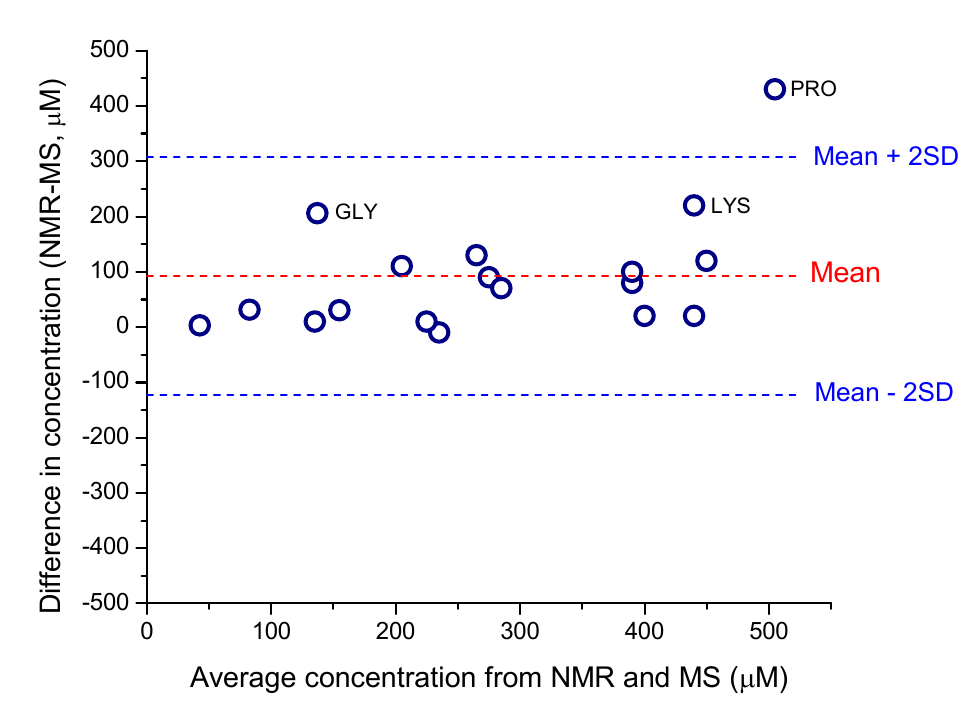
Figure 4. Evaluation of measurement agreement between 1 H NMR and LC-MS/MS based on Bland and Altman [59]. The difference of the mean measurement plotted against the average measured concentration compares the agreement between the measurements within the calculated standard deviation (SD). Concentration data are listed in Table S3. GLY = glycine, LYS = lysine and PRO = proline.